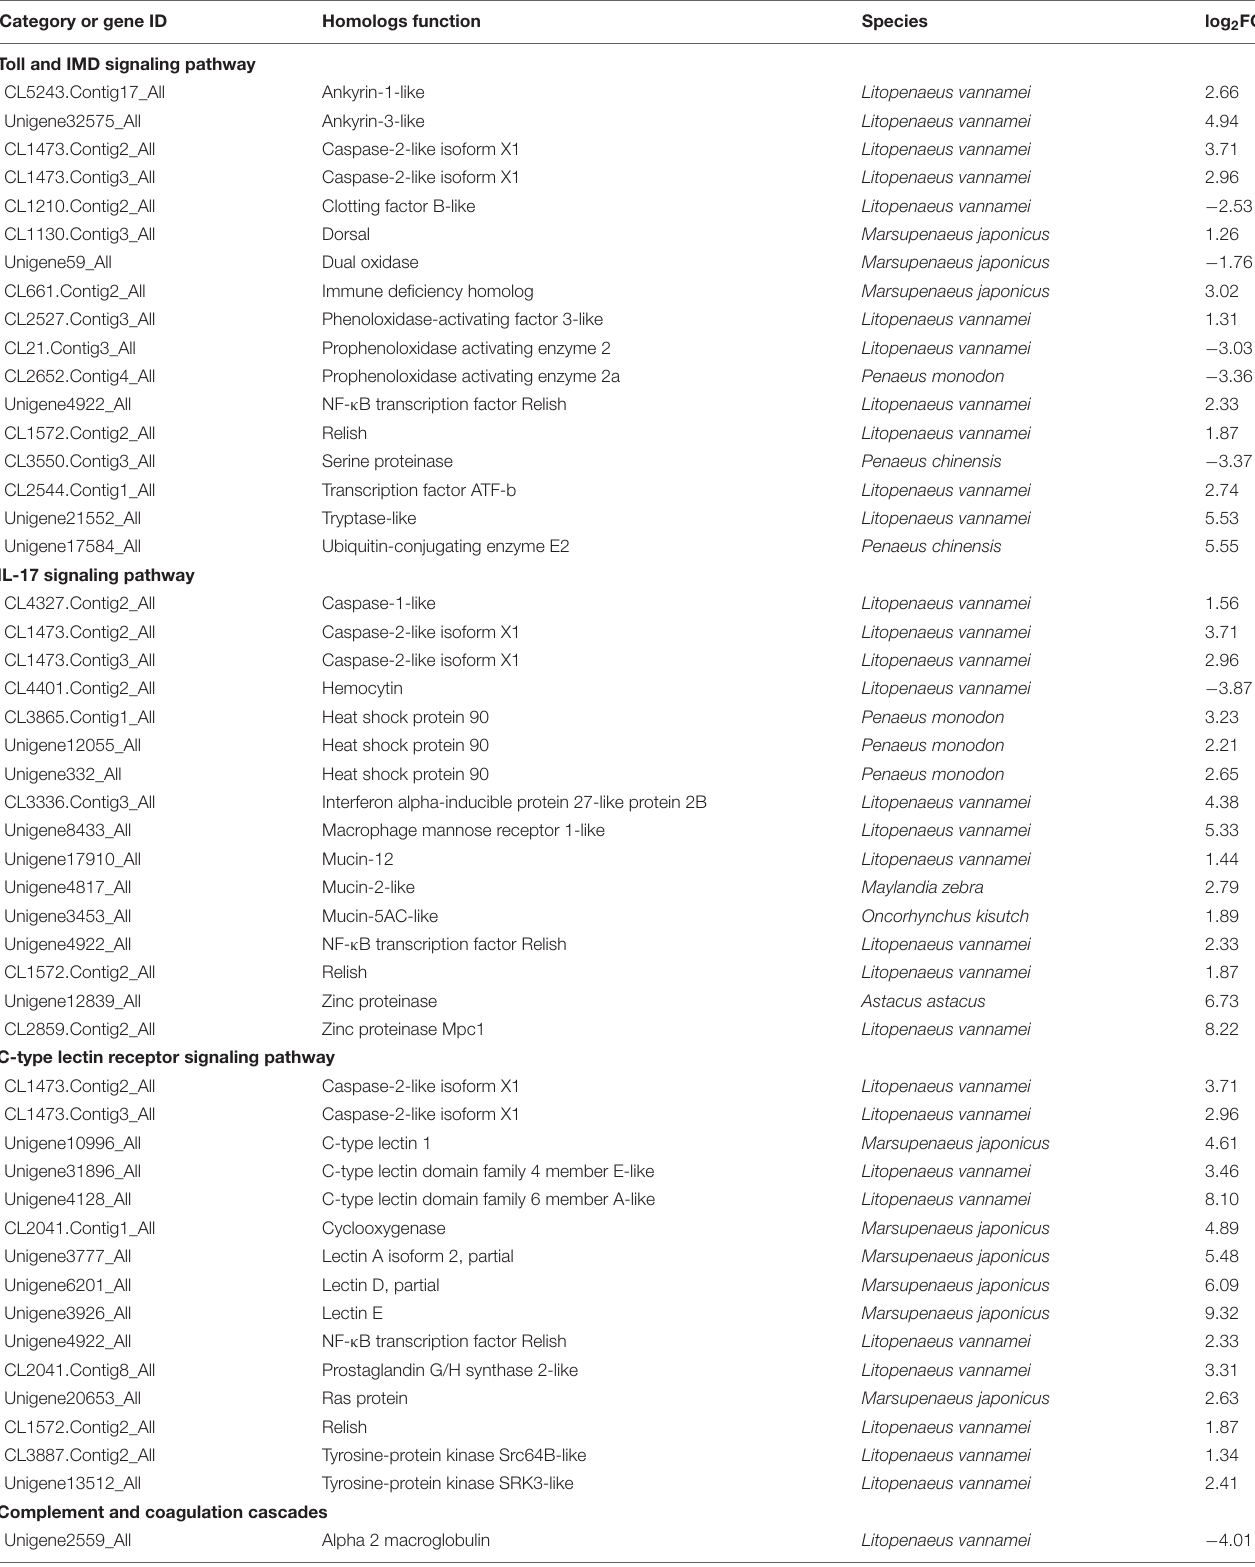
TABLE 3 | Candidate genes involved in M. japonicus immune response against DIV1. Category or gene ID Homologs function